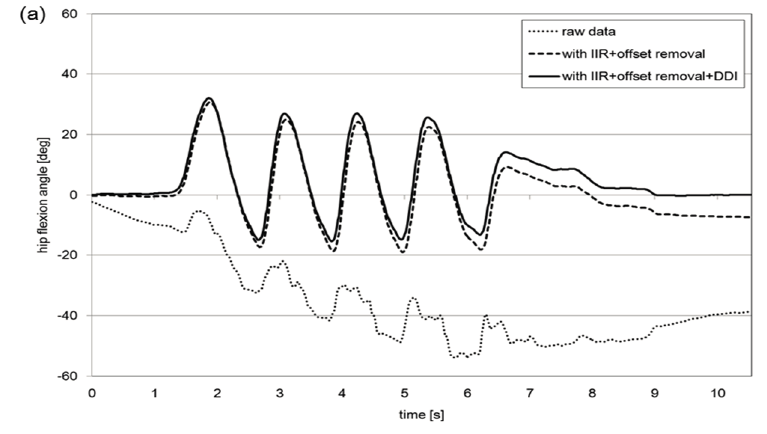
signal drift reduction protocol (raw data, IIR + offset removal, IIR + offset removal + DDI) for a volunteer. ( a ) Hip joint flexion angle; ( b ) knee joint flexion angle and ( c ) ankle joint flexion angle are